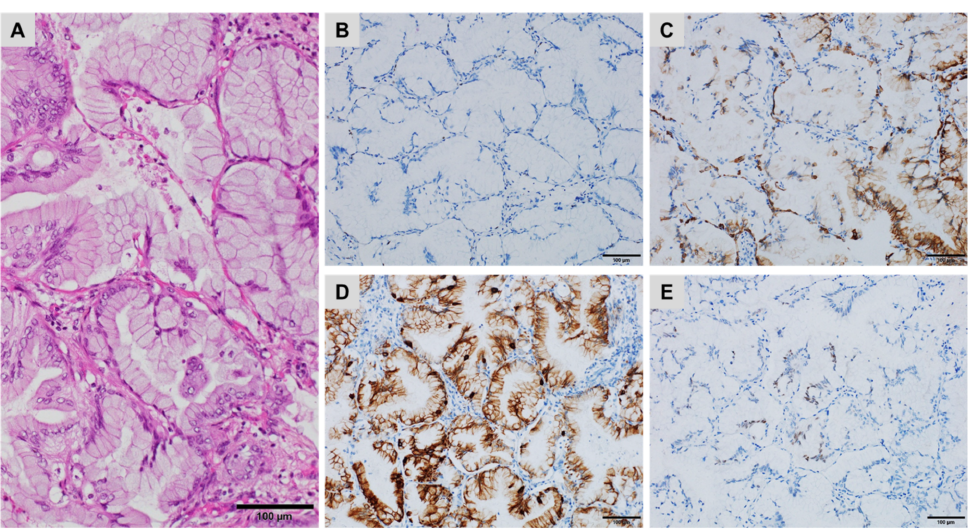
Figure 6. Primary mucinous pulmonary adenocarcinoma (( A ) haematoxylin, eosin and safran) showing ( B ) no staining for TTF1, ( C ) patchy staining for CK7, ( D ) strong staining for CK20 and ( E ) a few tumour cells stained for CDX2 (( B – E )